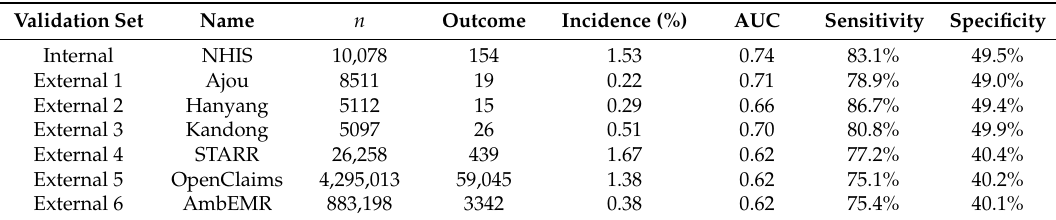
Table 2. Performance of the model in internal and external